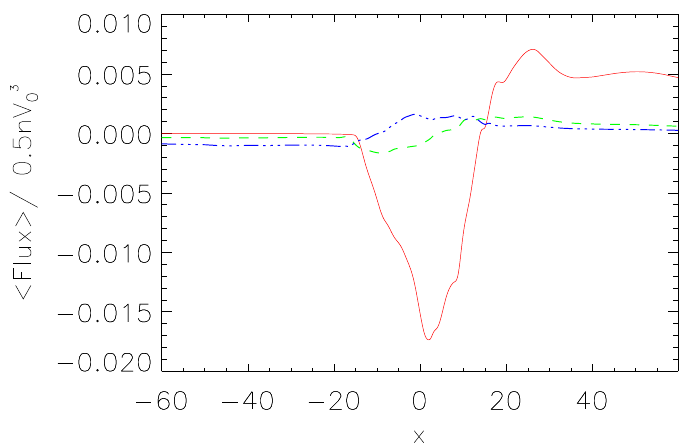
Figure 6. The x -component of the energy flux density averaged along the y coordinate for the three F k F L quantities (red line), (green line) and (cid:104) (cid:105) (cid:104) (cid:105) Figure 6.